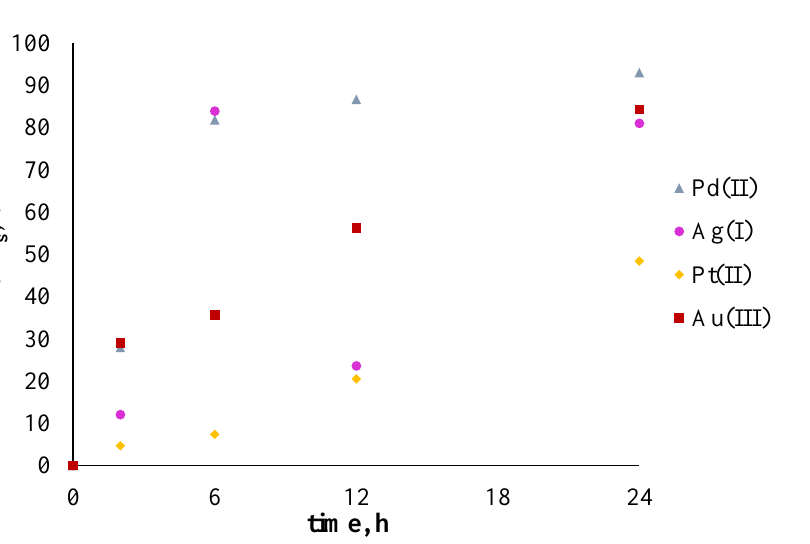
Figure 9. The percentage recovery (%R s ) of metal ions from the polymetallic solution using a polymer membrane containing salen. The given values of %R s carry ±0.01.